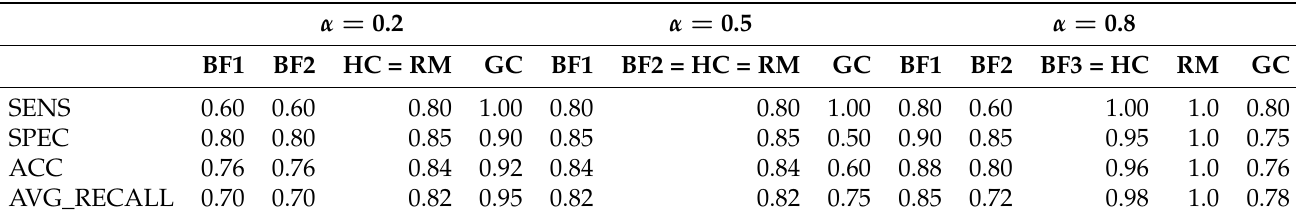
Table 9. Granger causality (GC) and Bayes networks (brute force networks (BFi) and hill climbing (HC)) performances with respect to the synthetic ground truth (Table 7) for data sets GCD_LLC_ α for α = ( 0.2,0.5,0.8 ) . α = 0.2 α =